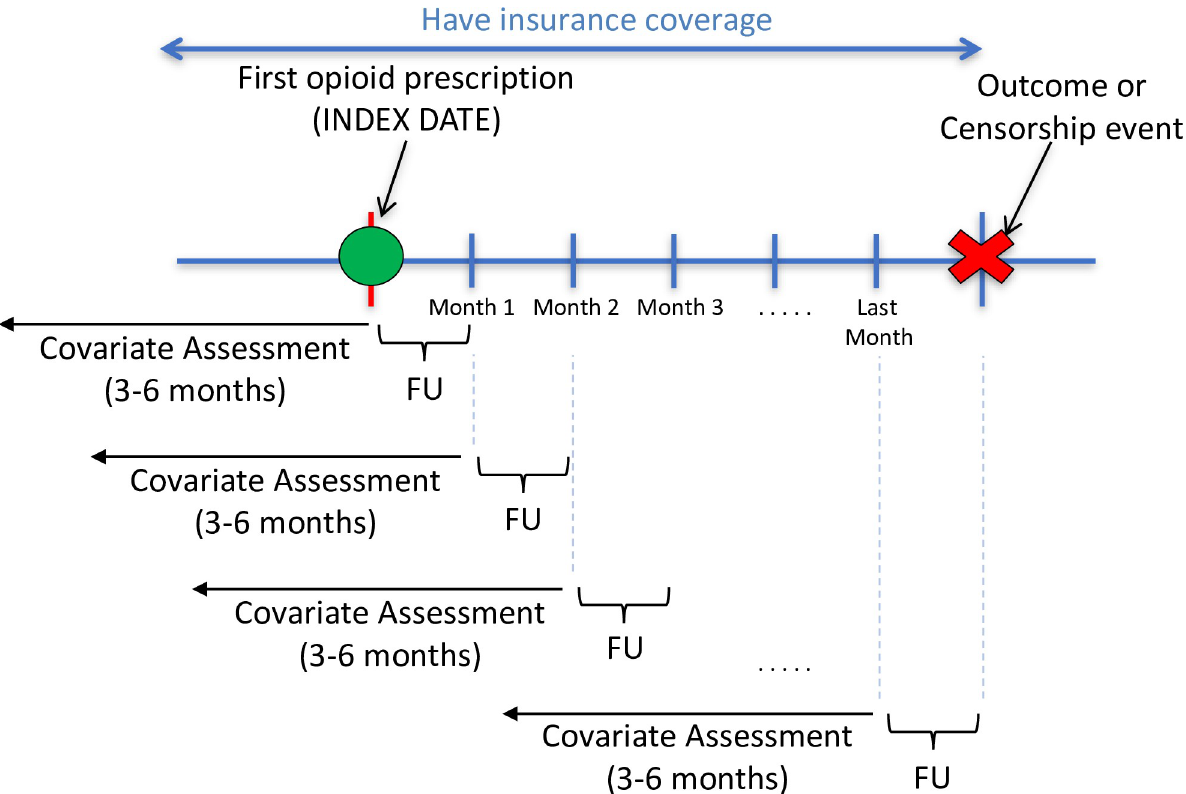
Fig 1. Study design diagram. Abbreviations: FU = follow up. The covariate assessment period was 3 months for medication dispensings and healthcare utilization and 6 months for medical diagnoses.